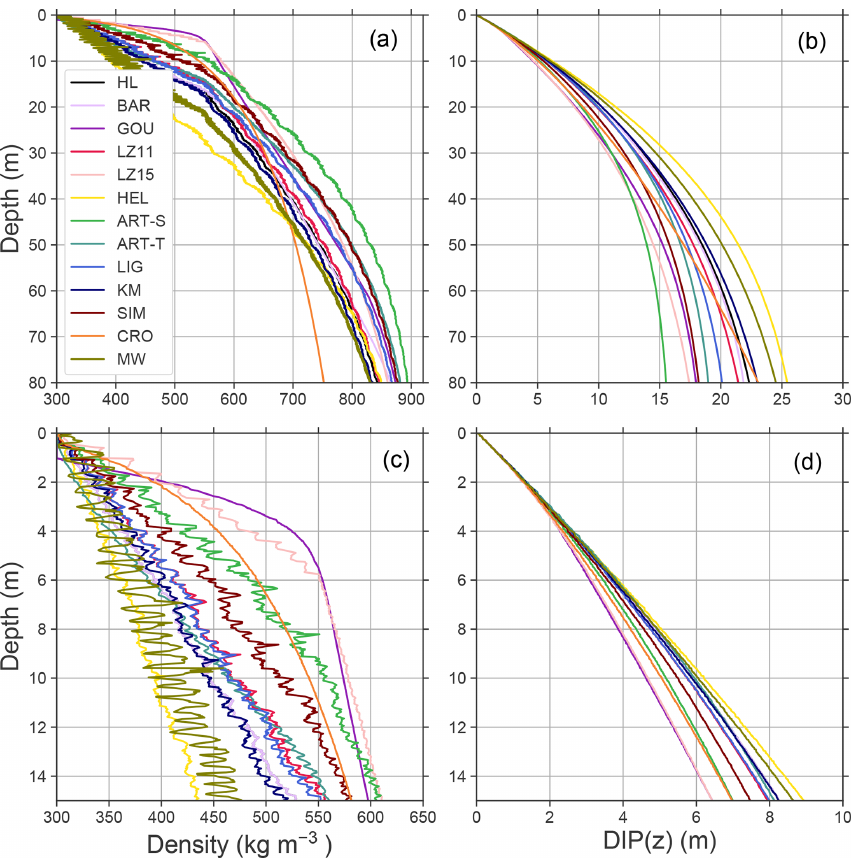
Figure 1. Profiles of depth–density (a, c) and depth–DIP (b, d) predicted by the models listed in Table 3 in the upper 80m (a, b) and 15m (c, d) of firn. Each panel is also included in the Supplement as a layered PDF